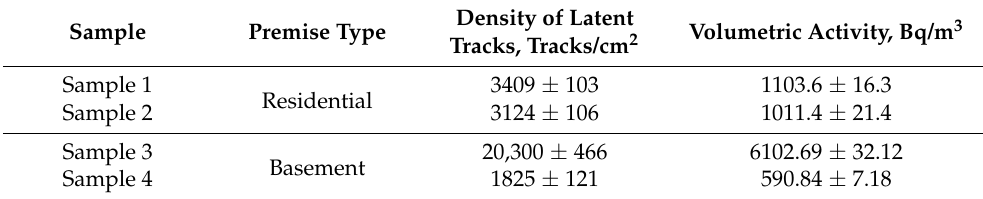
Table 1. Radon volumetric activity data (the measurement data presented in the table were deter- mined by calculating the density of latent tracks and the volumetric activity for all studied films with further determination of the average value and standard